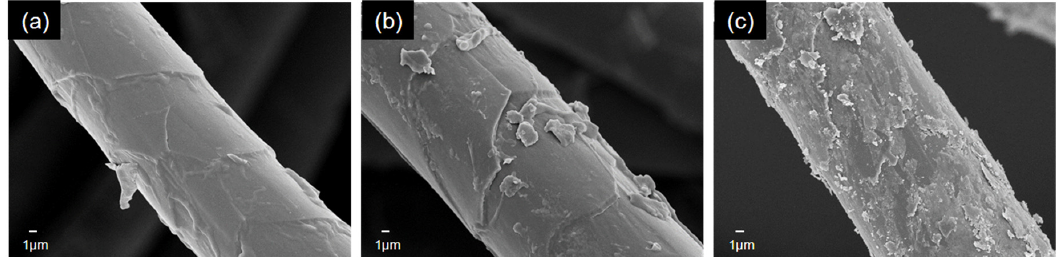
Figure 3. SEM images of cashmere fabric ( a ) pristine ( b ) with 5% coating and ( c ) with 10%